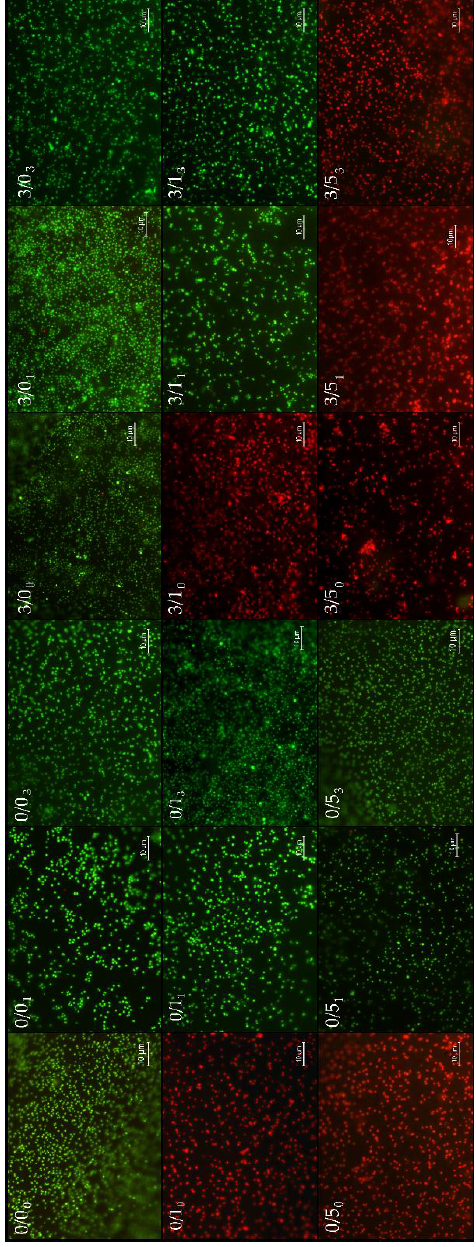
Figure 5. Representative fluorescence microscopy images of every PLA surfaces after bacterial adhesion. In the first row, we find the samples without CTAB from left to right 0/0 0 , 0/0 1 , 0/0 3 , 3/0 0 , 3/0 1 y 3/0 0 . In the second row, the samples with 1%/ w / w ), the same from left to right 0/1 0 , 0/1 1 , 0/1 3 , 3/1 0 , 3/1 1 y 3/1 3 . Then, in the last row are located the samples with 5% ( w / w ) CTAB from left to right 0/5 0 , 0/5 1 , 0/5 3 , 3/5 0 , 3/5 1 y 3/5 3 . Green colored bacteria indicate that they are alive, and when bacteria show a red color they are damaged or not dead.